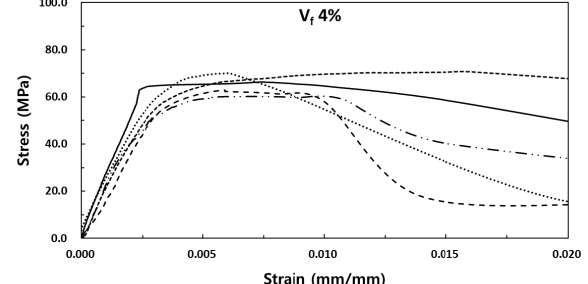
Figure 10. Stress-strain curve for the fiber volume fraction of 4%.